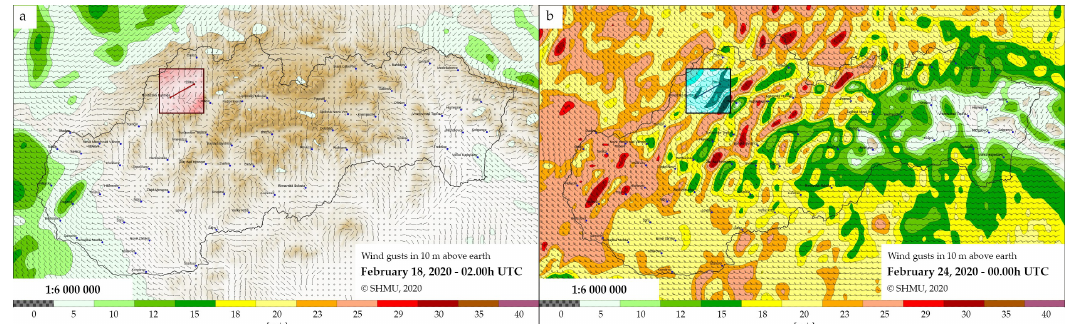
Figure 4. Wind conditions in selected country area. ( a ) A day of weak wind conditions with a wind speed up to 5 m/s. ( b ) A day of strong wind conditions with a wind speed up to 20 m/s. Highlighted squared boxes show the testing area, where the optical power wire cables were